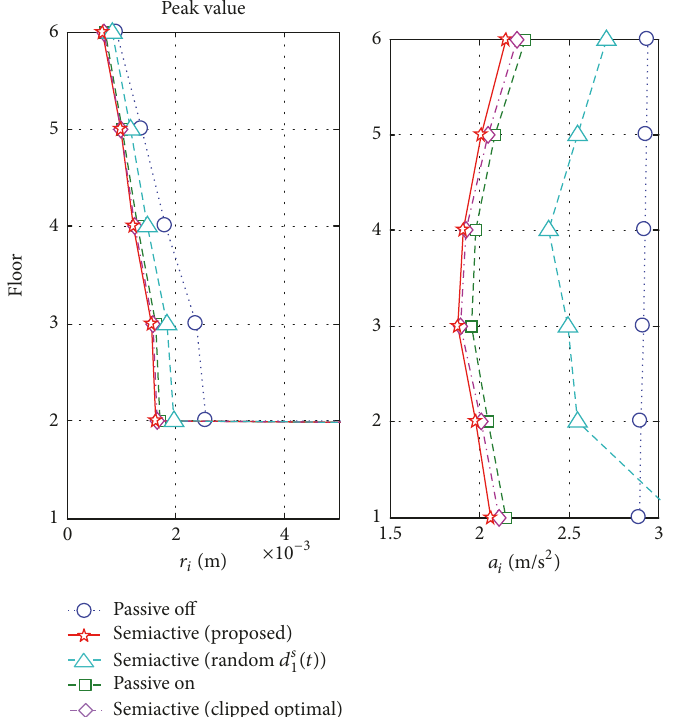
Figure 11: Simulation results for the BCJL1 earthquake disturbance; peak values of the relative displacement between neighboring floors and absolute acceleration of each